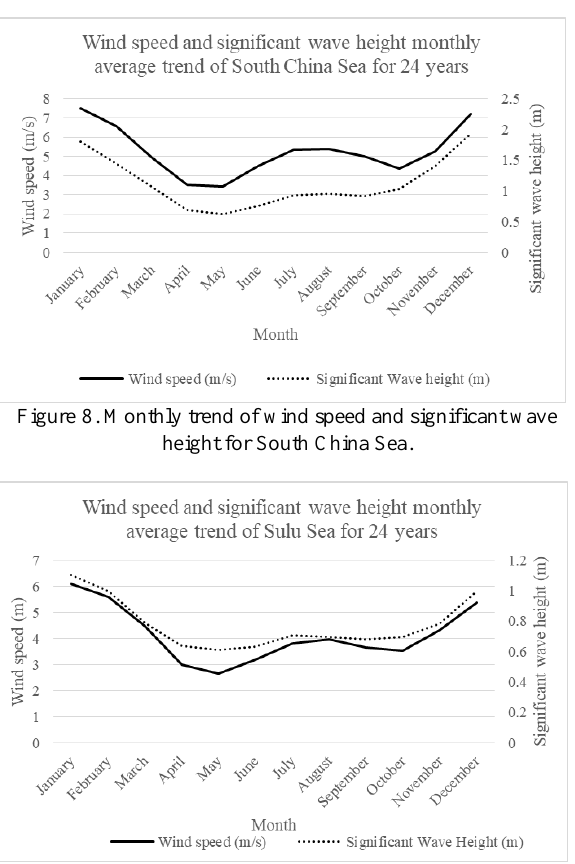
Figure 9. Monthly trend of wind speed and significant wave height for Sulu